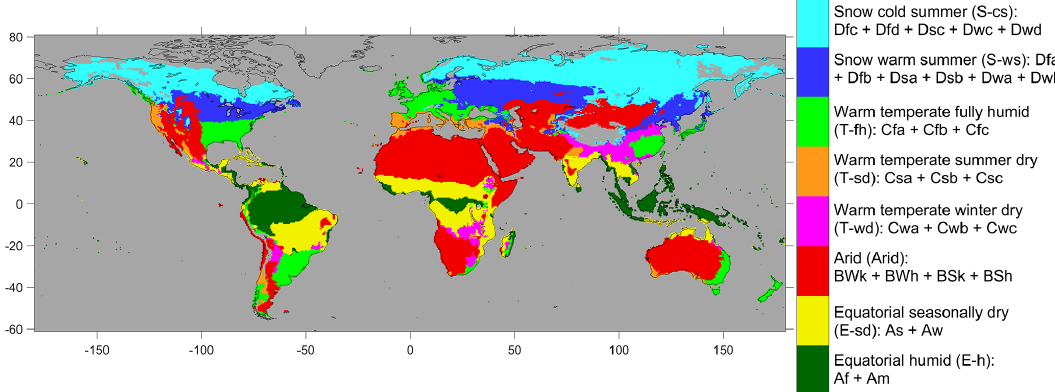
Figure 1. The Köppen–Geiger climate zones (Kottek et al., 2006) used for the analysis.